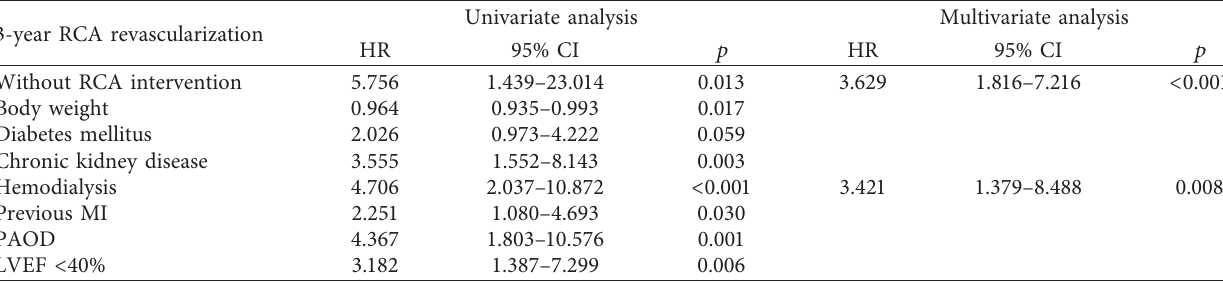
Table 4: Cox regression for the 3-year RCA